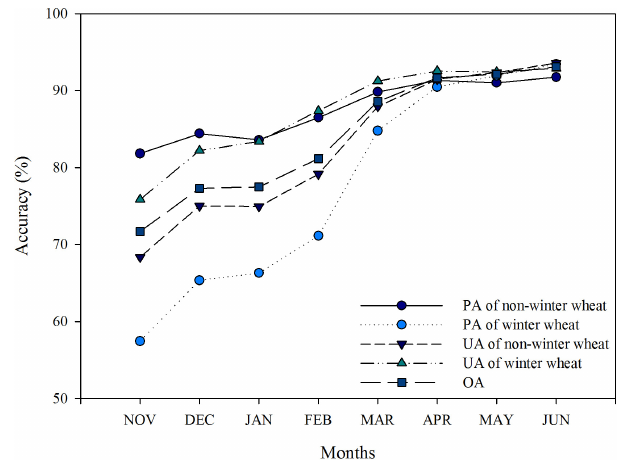
Figure 7. Evolution of producer’s accuracy (PA), user’s accuracy (UA), and overall accuracy (OA) with monthly increments. PA of non-winter wheat and PA of winter wheat represent the probabilities that the ground truth reference data of non-winter wheat and wheat class are correctly classified, respectively. UA of non-winter wheat and UA of winter wheat indicate the ratio of the total quantity of pixels correctly classified into the objective class (i.e., non-winter wheat and winter wheat) to the total quantity of pixels classified into the objective class using the proposed